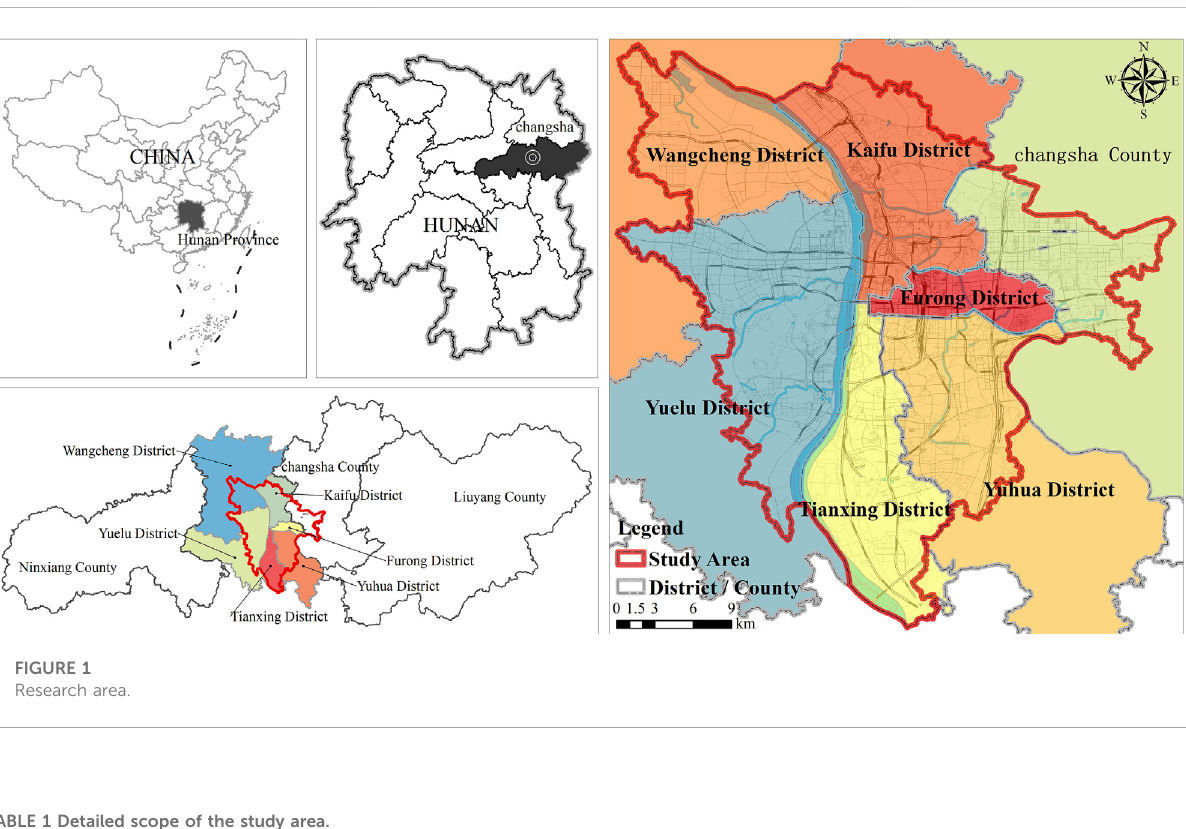
TABLE 1 Detailed scope of the study